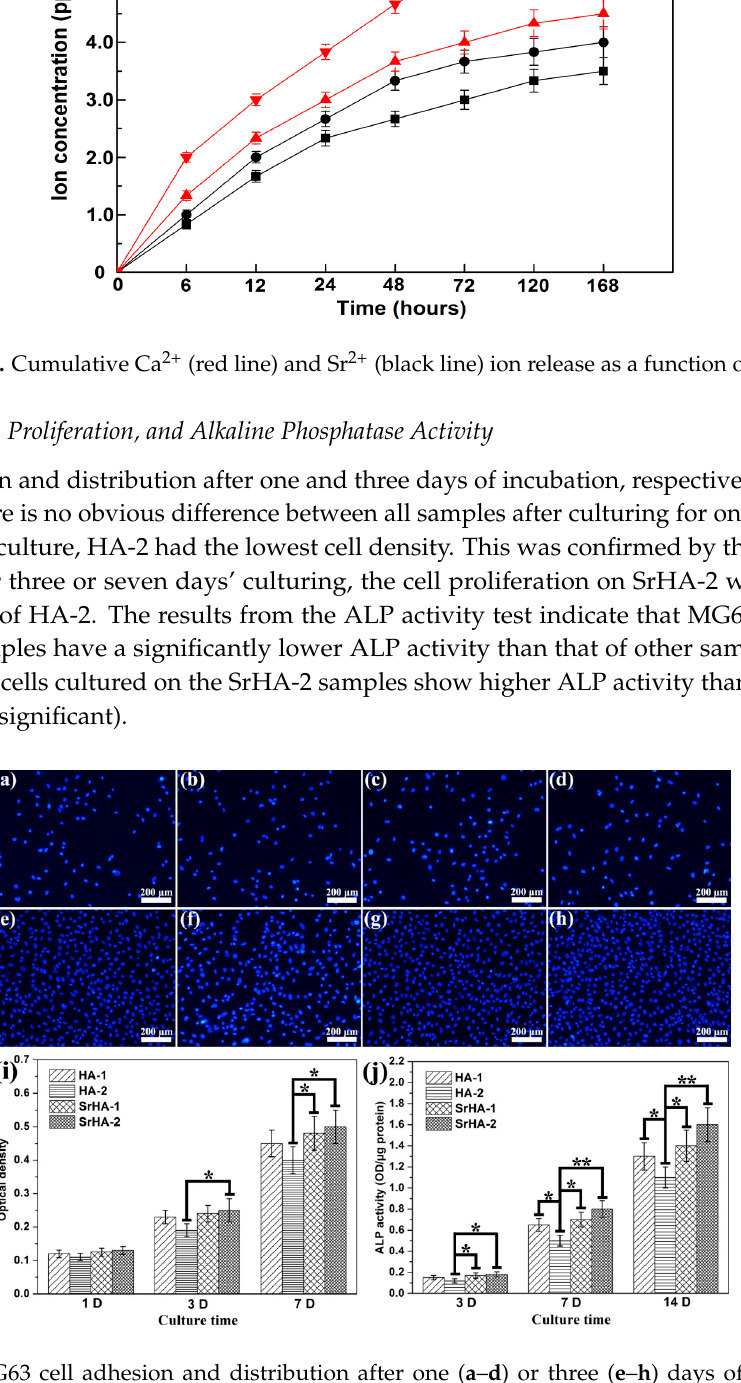
Figure 9. Gene expressions of MG63 cells cultured on different samples after incubation for three, seven, or 14 days: ( a ) ALP; ( b ) Runx2; ( c ) OCN. Statistically significant differences (* p < 0.05). 3. Discussion In this study, four different nanosized HA and SrHA were prepared. The results showed that the aspect ratio of the HA prepared by Ca(NO 3 ) 2 was lower than that prepared by CaCl 2 . It has been proven that using complexing agents or surfactants can arrest HA crystal growth [30]. Here, it seems that the a -plane growth of the HA is inhibited by Cl − , whereas the c -plane is inhibited by NO 3 − . In addition, SrHA nanorods greater than 100 nm in length were prepared by furnace cooling (providing enough time for crystal growth). The in vitro experiment showed that the biological performance of SrHA-2 (larger than 100 nm) is slightly better than that of SrHA-1 (but not significantly so). As is well known, SrHA possesses good biocompatibility. However, it would cause cytotoxicity after phagocytosis if the particle size was too small [31]. In the present study, SrHA-2 exhibited the largest size, which might make it unsuitable for filtrating cell membranes, thus, showing a better biological performance than that of SrHA-1. Meanwhile, SrHA-1 exhibited better cell proliferation and differentiation than HA-2. In this study, there were two main factors that might affect the biological performance: particle size and releasing ions. Due to the particle size of HA-2 being similar to that of SrHA-1, the difference could be attributed to the releasing ions of HA-2 and SrHA-1. The SrHA exhibited better cell proliferation and differentiation than HA, which could mainly be attributed to the release of Sr 2+ . Xin et al. found